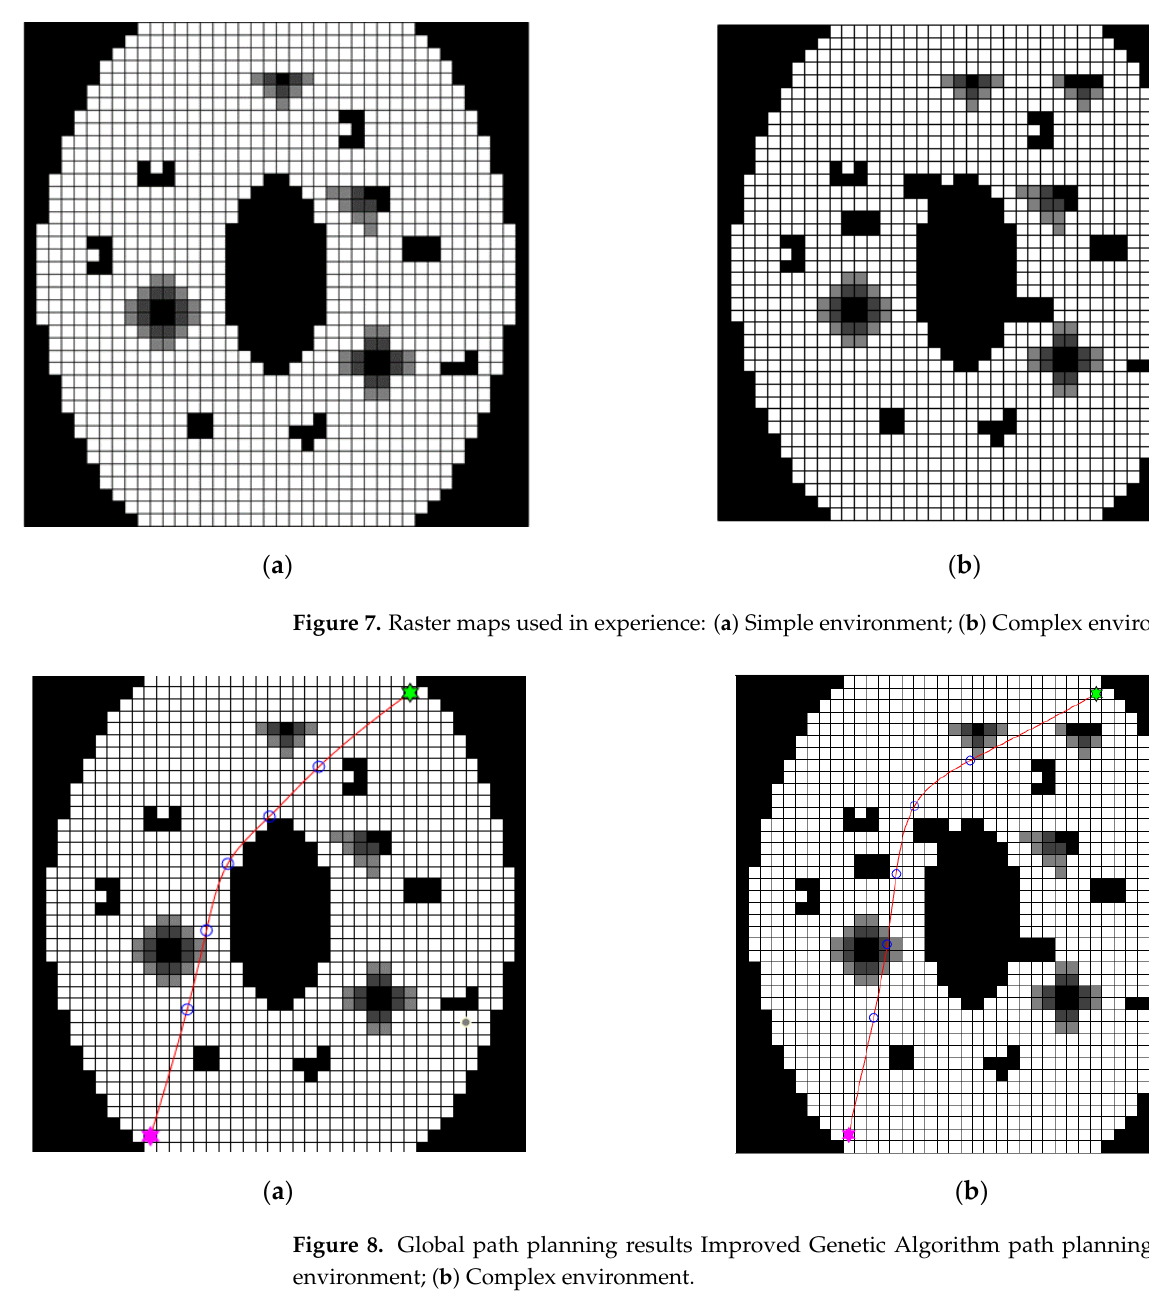
Table 2. Parameters of IPSOGA and GA.